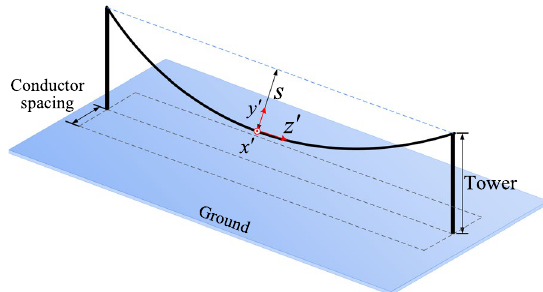
Fig. 9 Actual catenary